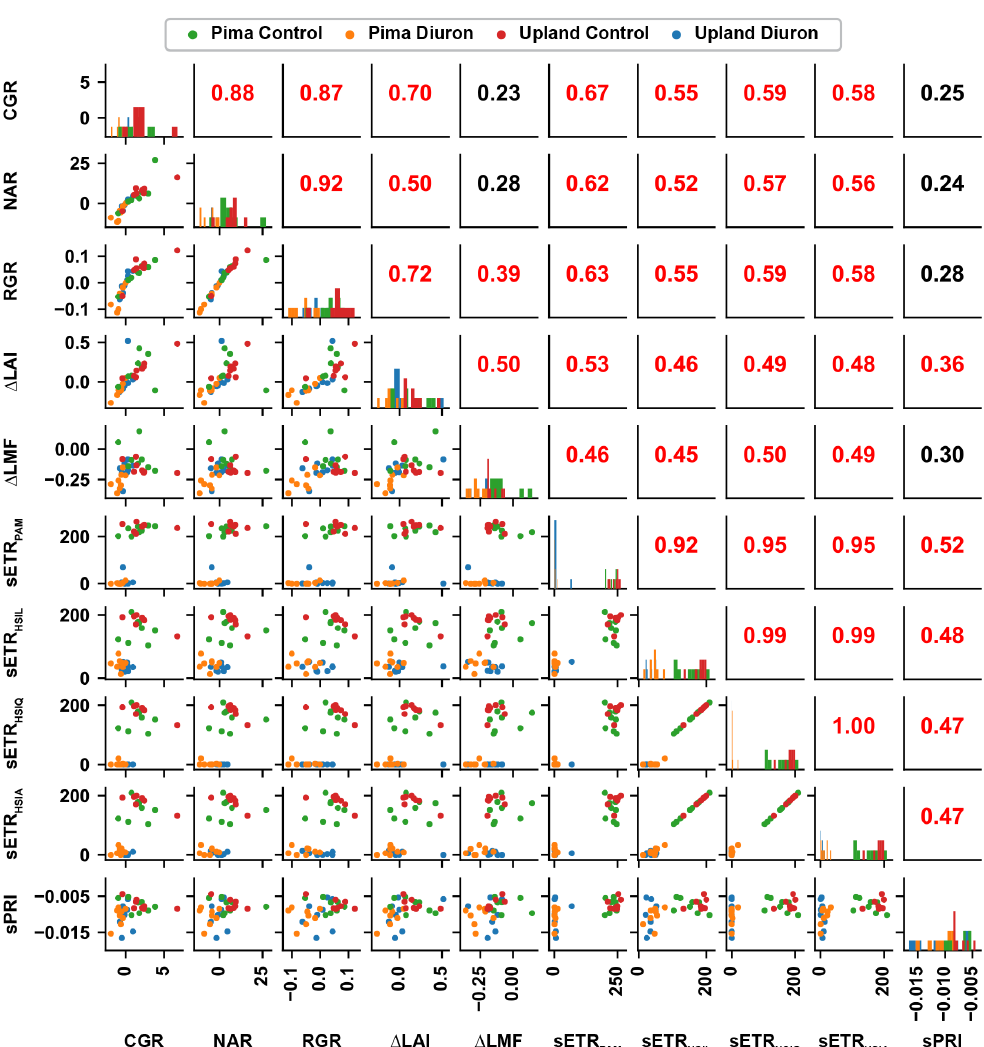
Figure 8. Pearson correlation values between growth traits and standardized ETR values estimated using four approaches. Values in the upper triangle are correlation values between traits indicated by a row and a column. Subplots along the main diagonal are the value distribution of individual traits, whereas subplots in the lower triangle are scattering plots between traits indicated by a row and a column. Significant ( p -value < 0.05) correlation values are rendered by red color, and values are otherwise black